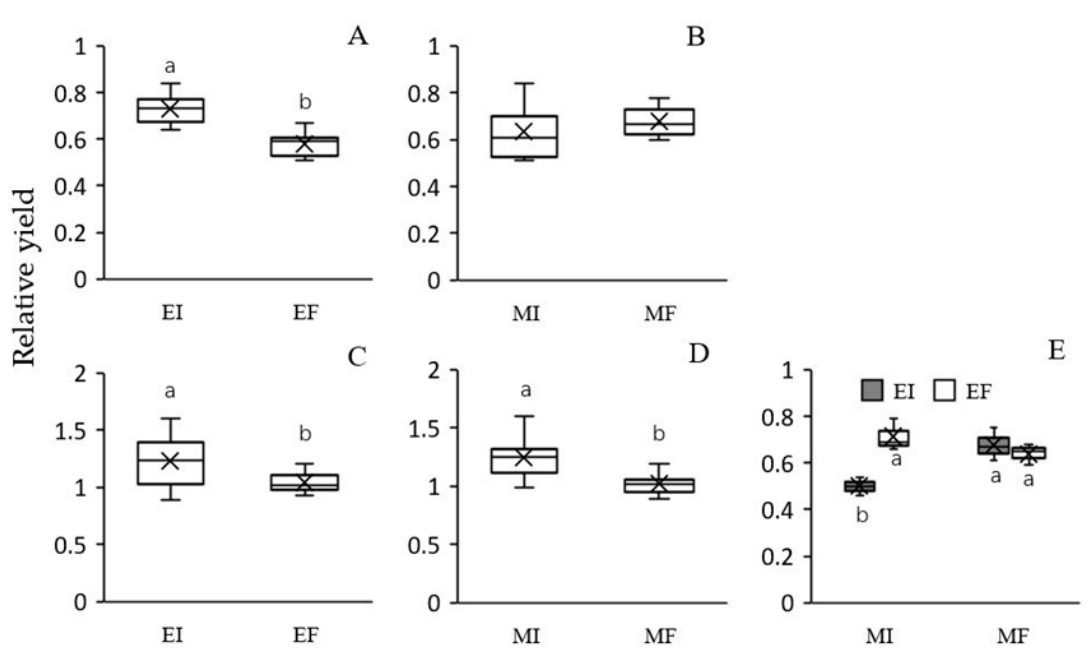
Figure 2. Effects of Epichloë endophyte colonization and soil microbes on the relative yield of Leymus chinensis both in intraspecific ( A ) and ( B ) and interspecific ( C ) and ( D ) competition and effect of the interaction between soil microbes and plant mixture type on the relative yield of Stipa krylovii ( E ). Values are means ± SE ( n = 5). The different letters above bars denote means that are significantly different among treatments ( p < 0.05). EI, Epichloë endophyte-colonized L. chinensis ; EF, endophyte- free L. chinensis ; EIS, S. krylovii grown with EI L. chinensis ; EFS, S. krylovii grown with EF L.chinensis ; MI, soil microbe inclusive; MF, soil microbe free. Symbol ‘×’, horizontal line in the box, top and bottom of box edges and bars indicate the average value, median, 25% and 75% quartiles, and 5% and 95% quantiles, respectively.